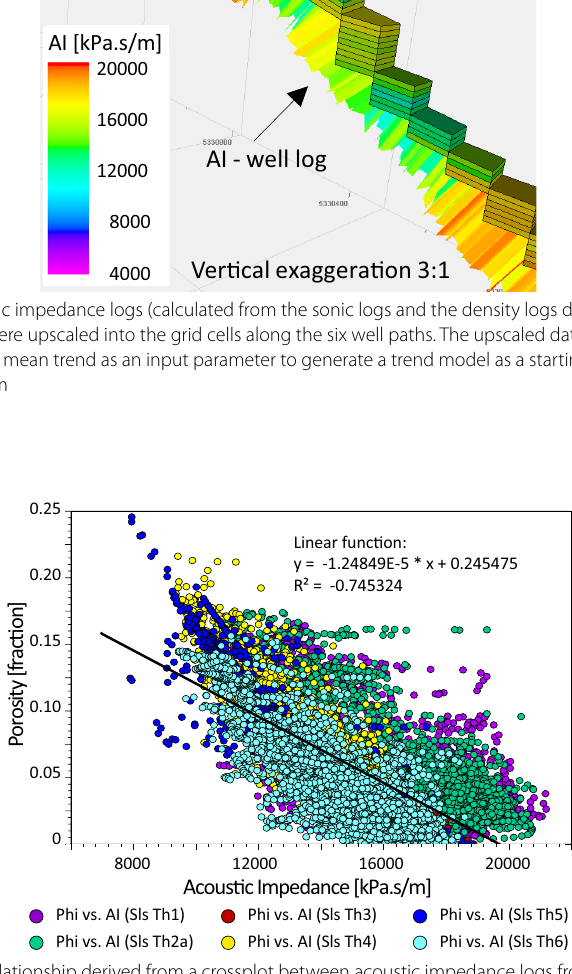
Fig. 8 Property relationship derived from a crossplot between acoustic impedance logs from the well-seismic tie carried out in this study and porosity calculations from sonic logs carried out by the Technical University of Munich (Pfrang 2020). With the linear function, the AI model from the inversion was converted into a porosity model of the